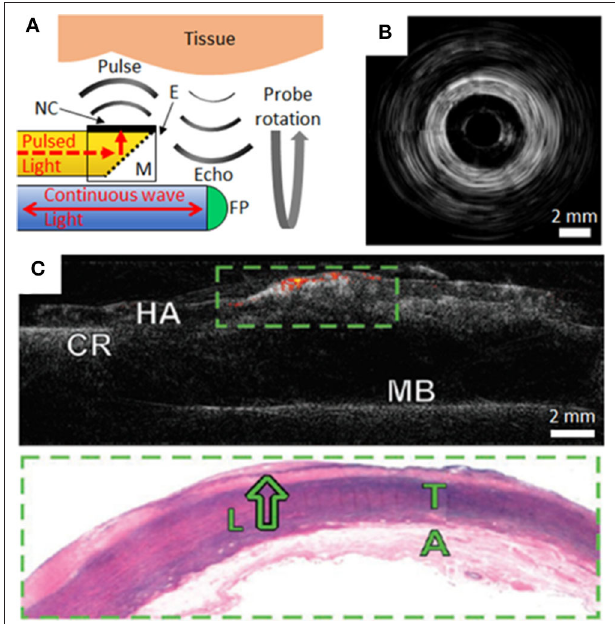
FIGURE 2 | (A) Schematic of side-viewing optical ultrasound imaging probe with pulsed excitation light transmitted along an optical fiber (yellow), reflected at a mirror (M) and absorbed at the nanocomposite (NC) coating surface of an epoxy-based (E) optical transducer housing. Ultrasound pulses reflect from tissue and the echoes are received through interferometric interrogation of the Fabry-Pérot (FP) cavity at the distal end of the receiving optical fiber (blue). The probe is rotated about its axis to achieve circumferential imaging. (B) Rotational optical ultrasound images obtained within an ex-vivo swine carotid artery (20). (C) Co-registered optical ultrasound (gray-scale) and photoacoustic images of human aortic tissue (HA) using a gold nanoparticle/PMDS composite transmitter. Areas of lipid are displayed as a color signal. The tissue was secured to a cork ring (CR) and metal base (MB) for imaging. Corresponding histology of the green boxed area highlights a lipid pool (L), tunica media (T) and adventitia (A) (